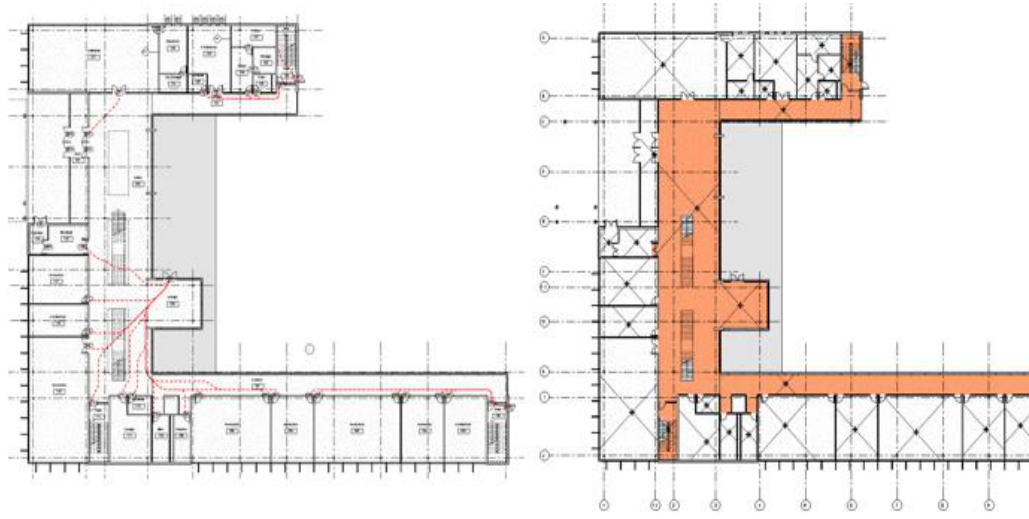
Figure 10. Escape route planning in Revit environment using an open API visual program.